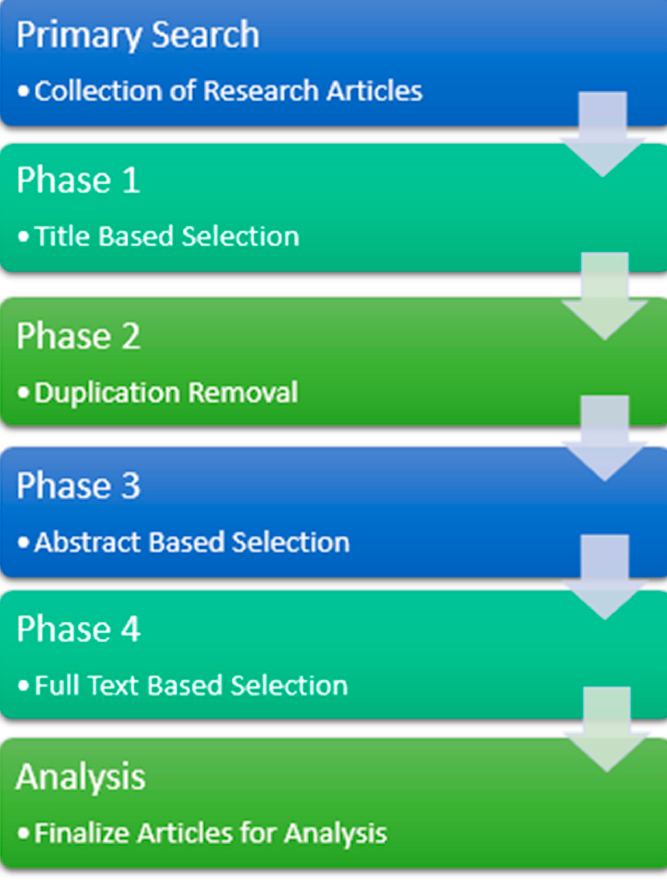
Figure 2. Selection Procedure.